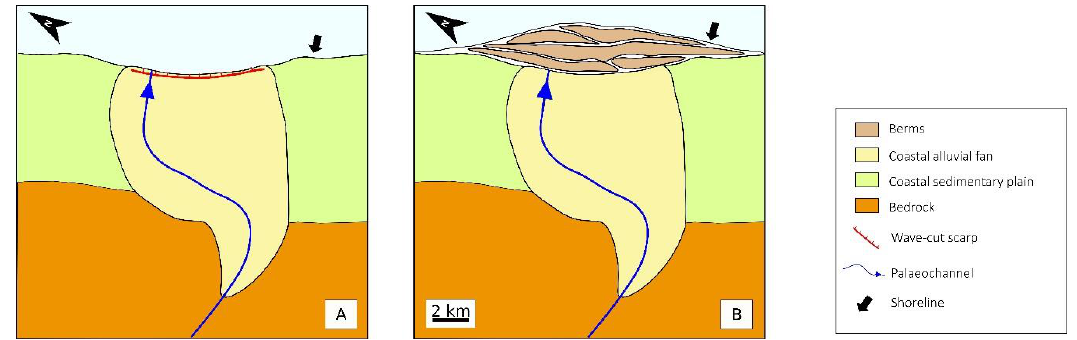
Figure 3. Two key stages in the Holocene evolution of the coast of Senigallia. ( A ) During the maximum marine ingression (mid Holocene), a scarp was formed by erosional removal of the external part of the upward-convex Misa fan. ( B ) In Roman times, due to the formation of berms leaning against the scarp, the coastline slightly shifted seawards, also originating a ridge and swale topography. The site is located immediately upstream of the partially buried slope (now largely masked by buildings and recent sediments), which indicates the maximum Holocene marine transgression (about 3 to 5 ka ago). The modest height of the slope is directly connected to the extremely flattened shape of the fan of the Misa river.